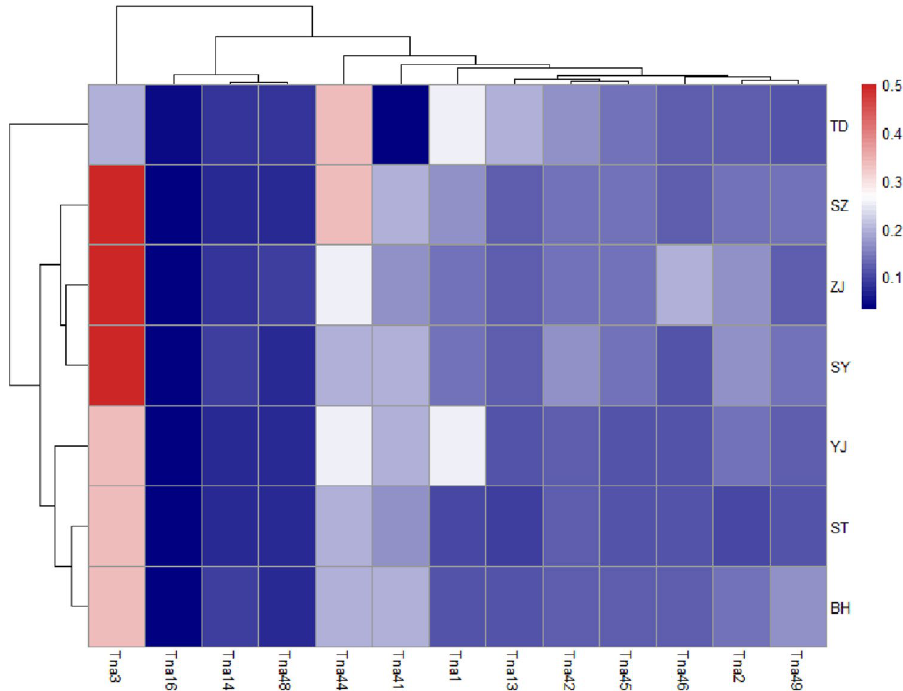
Figure 6. Heat map representing allele frequency for 13 loci in all 7 population as the gradual increase in color density from lighter color (blue) to darker color (red) means the increase in the allele frequency as the red color, which indicates the highest value of allele